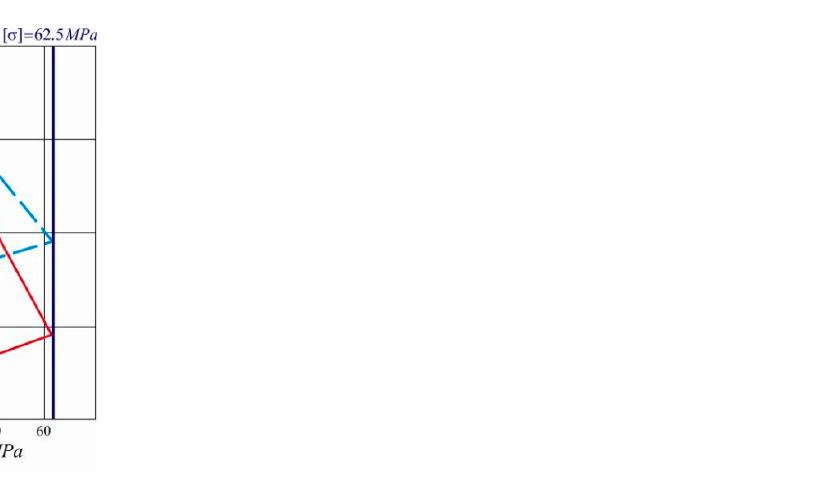
Figure 5. Distribution of maximum stresses along the fibula length from the action of the tightrope tightening force: 1—the tightening force for a tall person is P = 160 N; 2—the tightening force for a small person is P = 75 N.